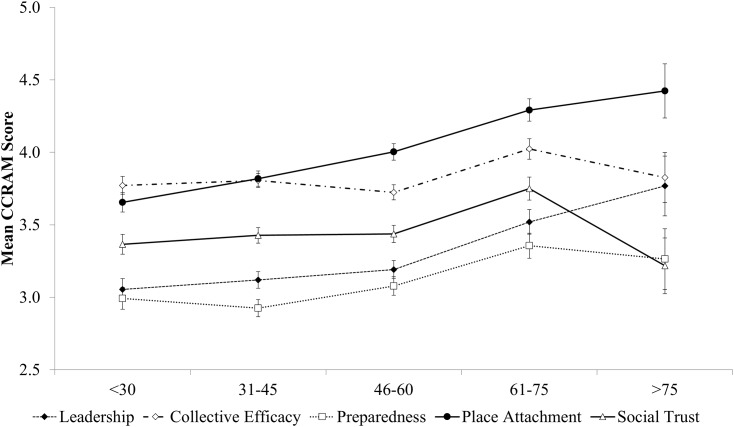
Mean CCRAM scores by age.Notes: spline knots occur at age 27, 52, 72 and 83. Ages over 75 were characterized by scarce and heterogeneous data (n = 23).